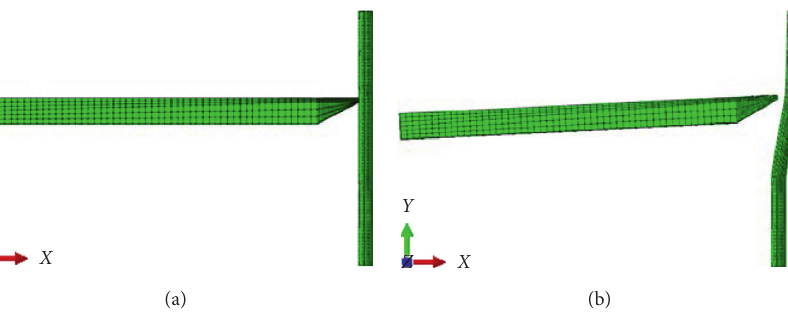
Figure 14: The positions of the pier (a) before the ship-pier collision and (b) after the collision.